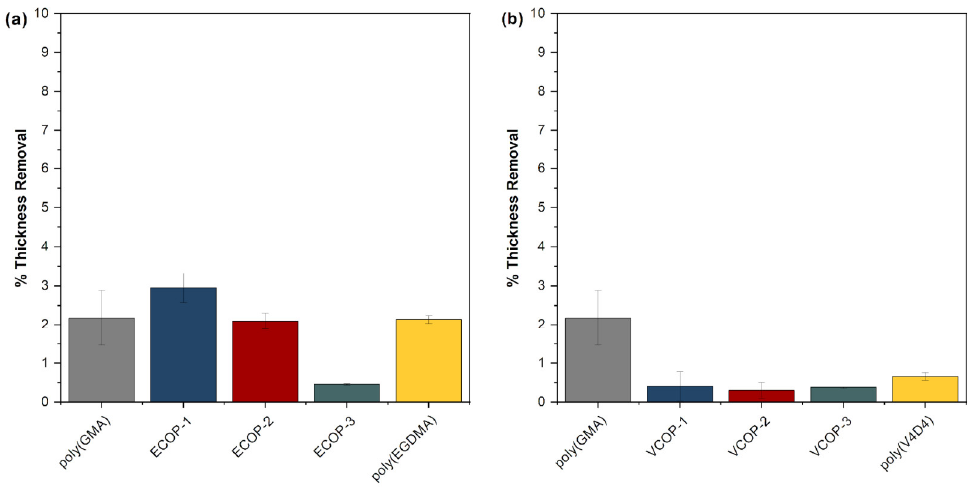
Figure 10. Relative change in film thickness for homo and ( a ) poly(GMA-co-EGDMA) ( b ) poly(GMA-co-V4D4) copolymer coatings immersed in water for 48 h.